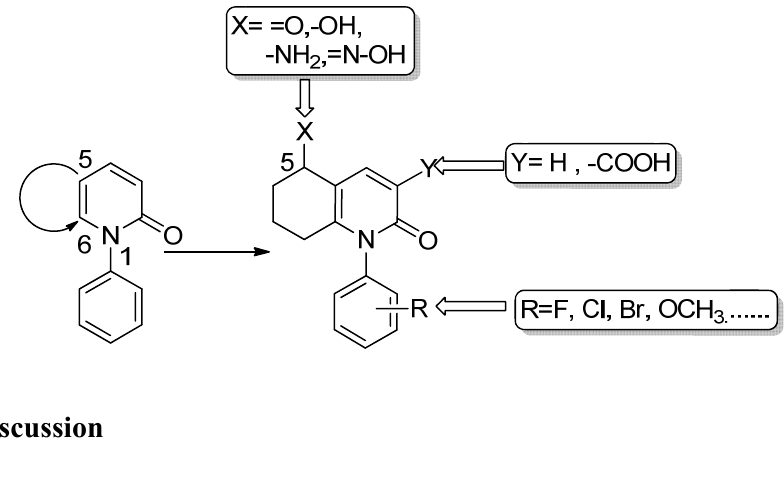
-substituted phenylhydroquinolinone 1